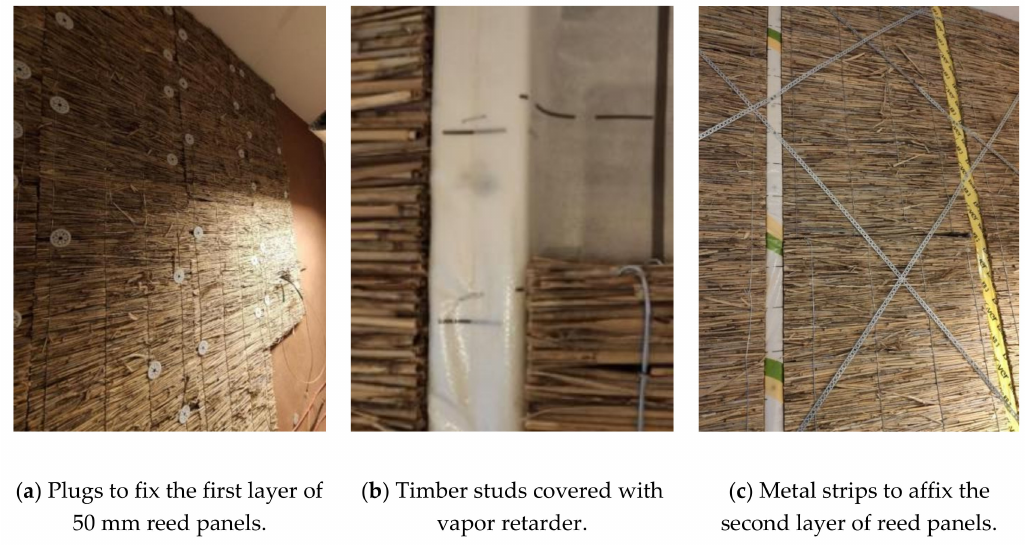
Figure 3. Building the test wall.